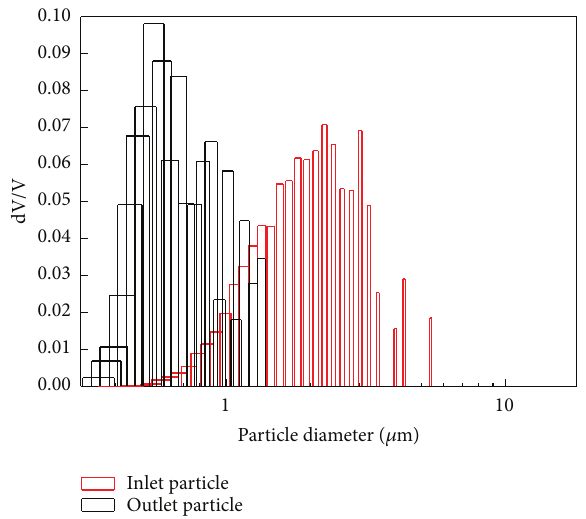
Figure 10: PSD measured by the on-line particle sampling system.